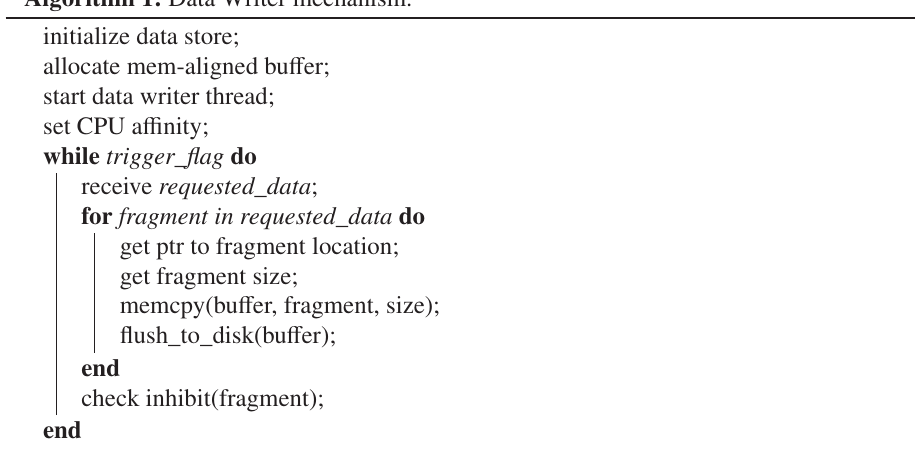
system and to reduce the number of context switches during the execution and that can lead to a loss in the total bandwidth. In addition, ensuring that the memory bu ff er is aligned is necessary when using the O_DIRECT flag. Initial tests showed that a 512 bytes alignment is not compatible with Micron X100 drive and therefore a 4 KiB alignment was